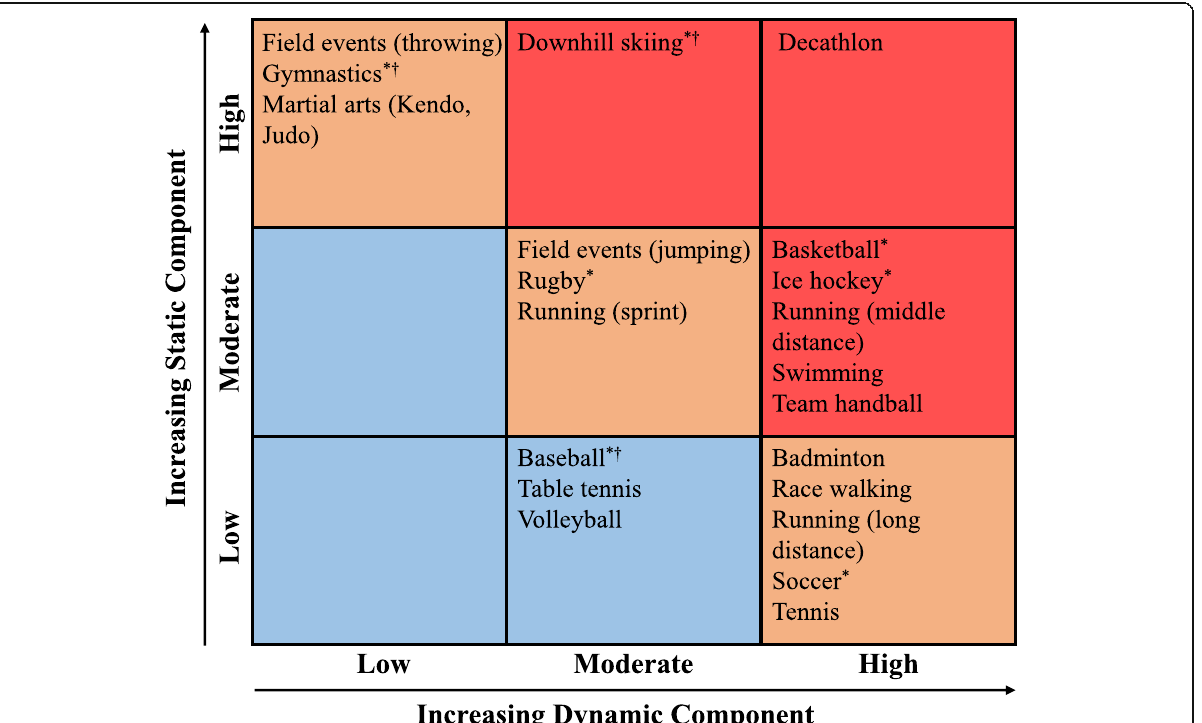
Fig. 2 Classification of university sports club membership into three categories, low (blue), moderate (orange), and high (red) total cardiovascular intensity. The static component was defined as the estimated percent of maximal voluntary contraction reached; the dynamic component was defined as the estimated percent of maximal oxygen uptake achieved. * Danger of bodily collision. † Increased risk of syncope occurs